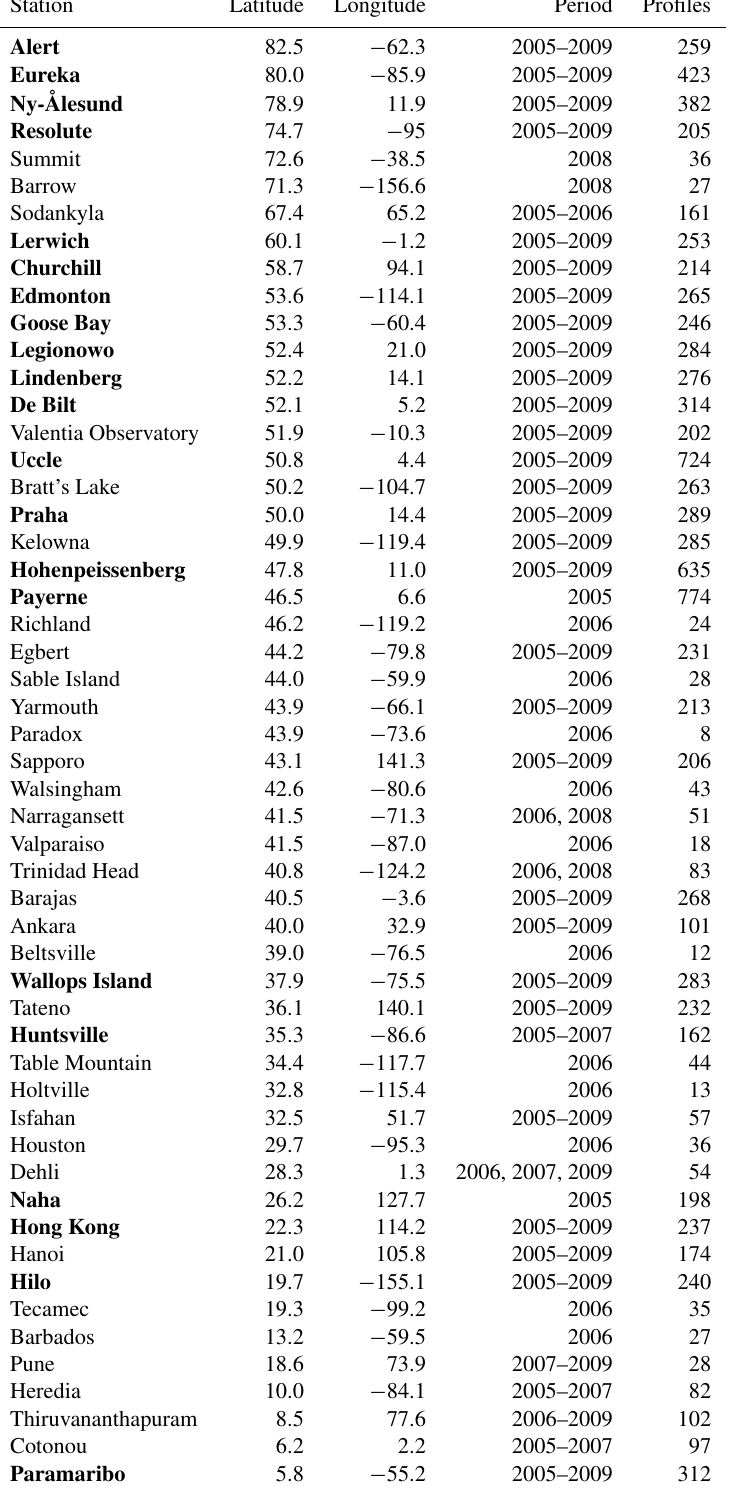
Table 2. Ozonesonde observation sites used in this study. All the data are used for the evaluation of reanalysis data (Sect. 3), whereas selected observations (shown in bold) based on the compilation by Tilmes et al. (2012) are used for the evaluation of ACCMIP models and to investigate ozonesonde sampling biases (Sects. 4 and 5).